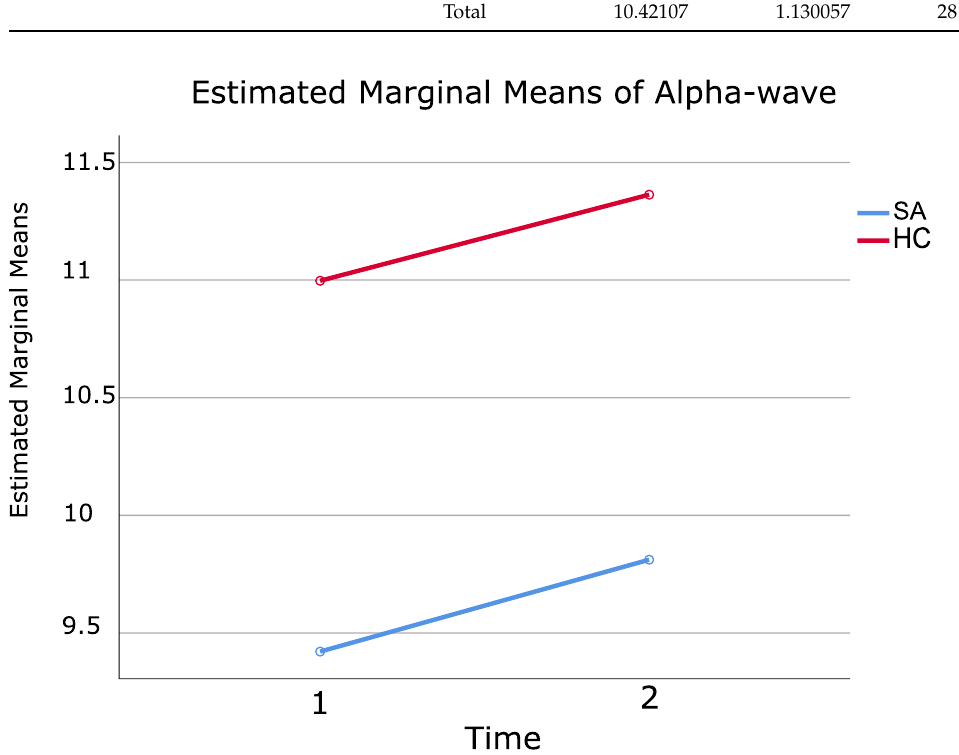
Figure 3. Displayed means for alpha-wave measured at Time 1 (baseline) and Time 2 (after 20 sessions of LTH) for SA (shown in blue color) and HC (shown in red color) groups.